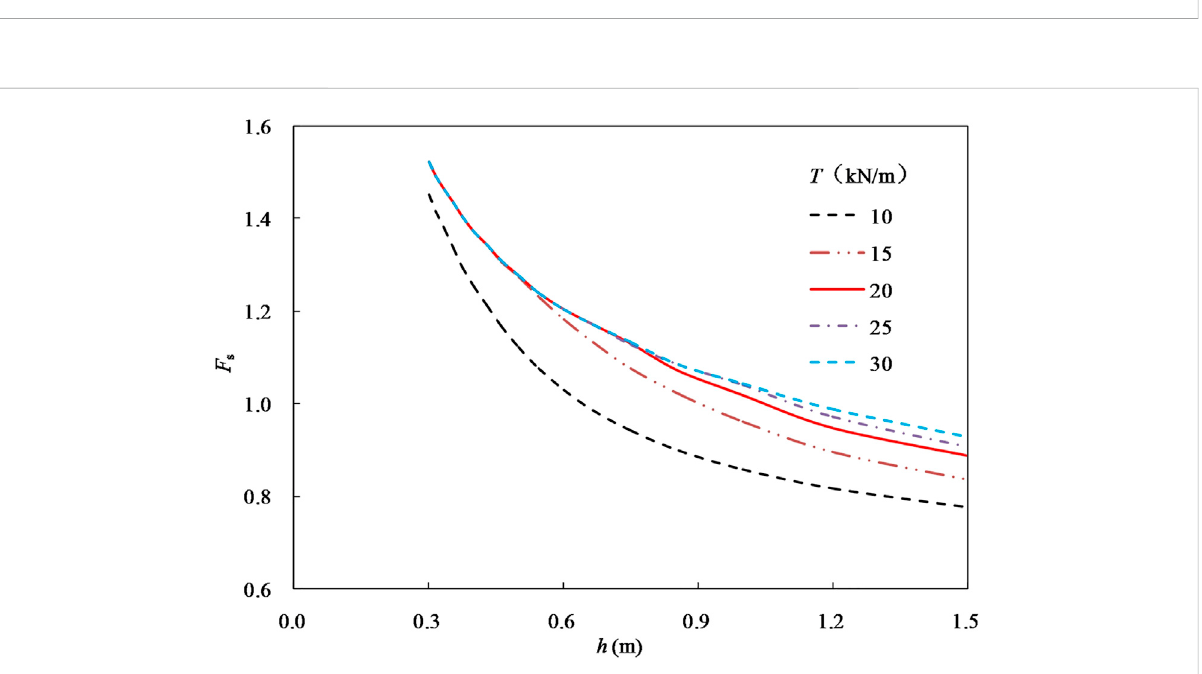
FIGURE 8 Relationship between F s and h under different